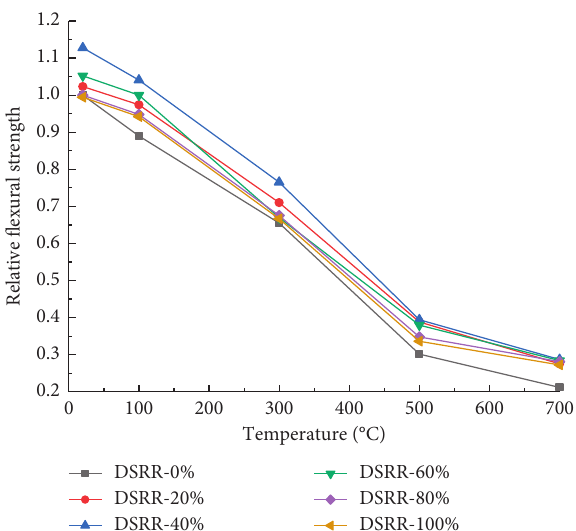
Figure 15: Relation between relative flexural strength and temperature.